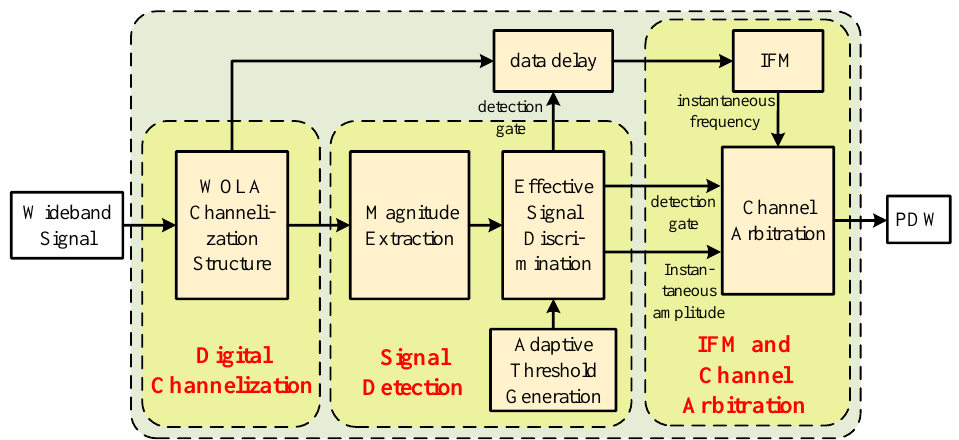
Figure 4. The detailed flow of the proposed digital channelized receiver